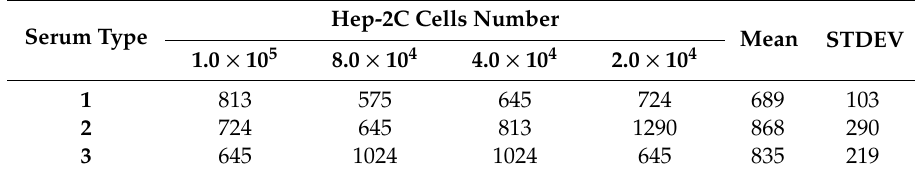
Table 4. Impact of HEp-2C cell number variability on anti-poliovirus sera titers generated by MPBN